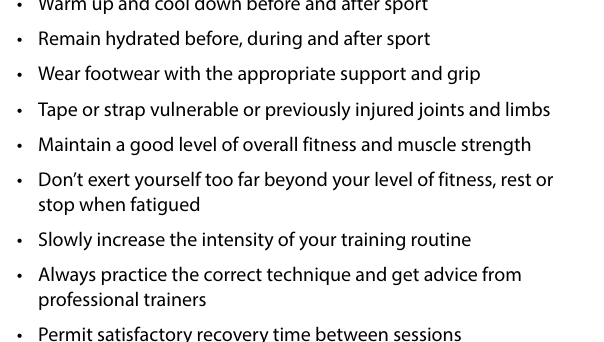
Figure 4: Types of knee injuries